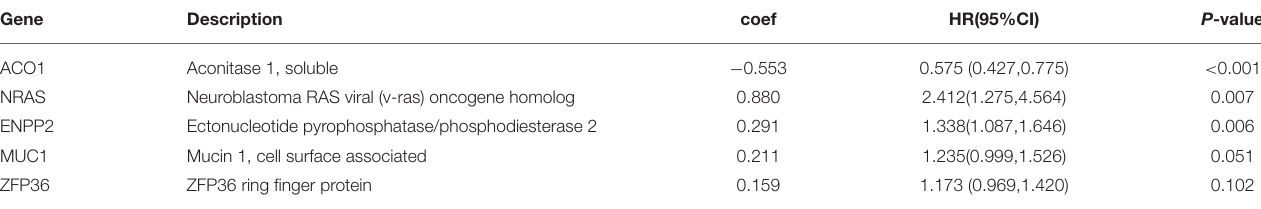
TABLE 1 | Multivariate Cox regression analysis of the five FRGs.